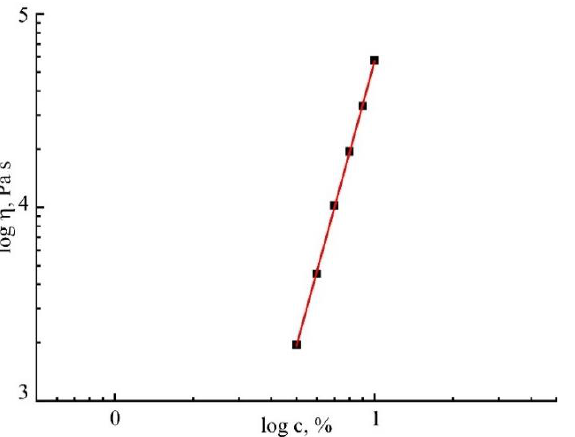
Figure 8. Concentration dependence of the viscosity cellulose solutions of flax noils in NMMO.